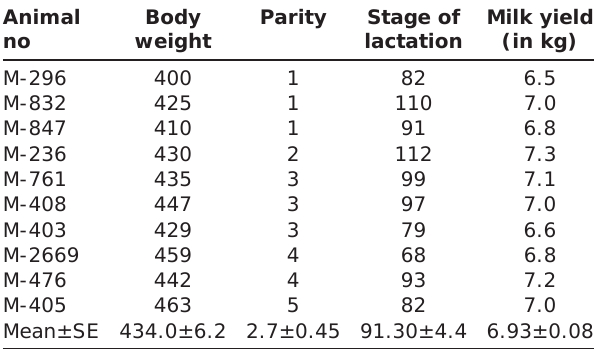
Table-2: Details of experimental buffaloes: Group II (foggers).